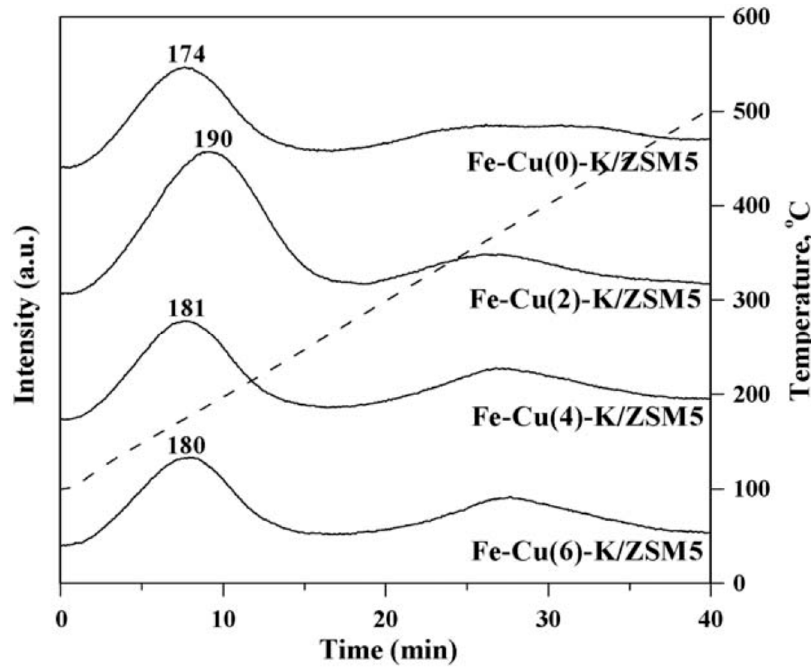
Figure 13. The NH 3 -TPD profiles over Fe–Cu–K/ZSM-5 catalysts. Reprinted with permission from [99]. Copyright (2009) Elsevier Science Inc., New York, America.